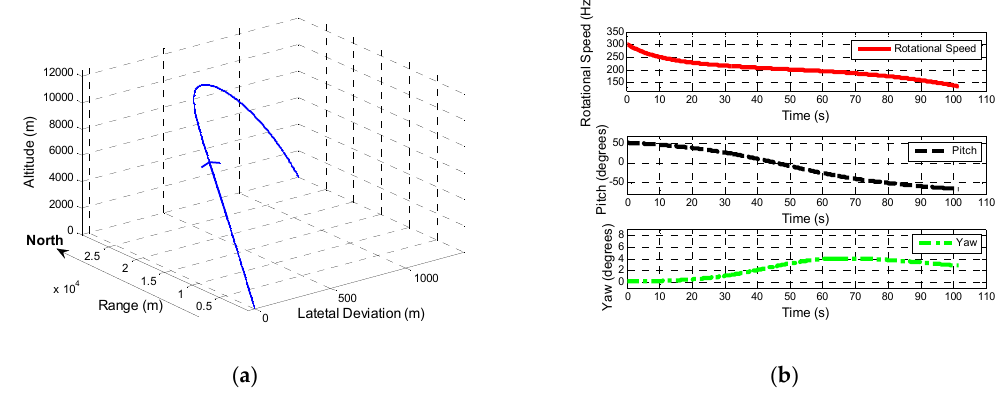
Table 2. Properties of projectile and field.